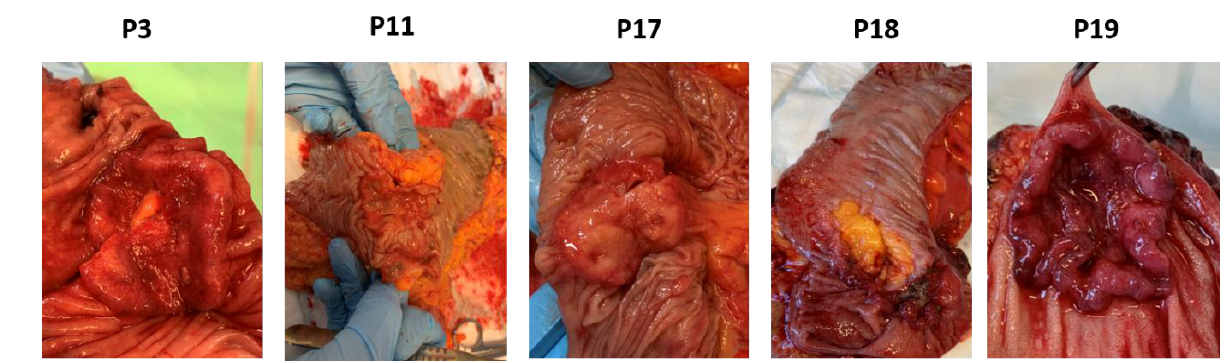
Figure 6. Pathology of CRC tumors from patients (p) 3, 11, 17, 18 and 19. Table 2. Animal and engraftment